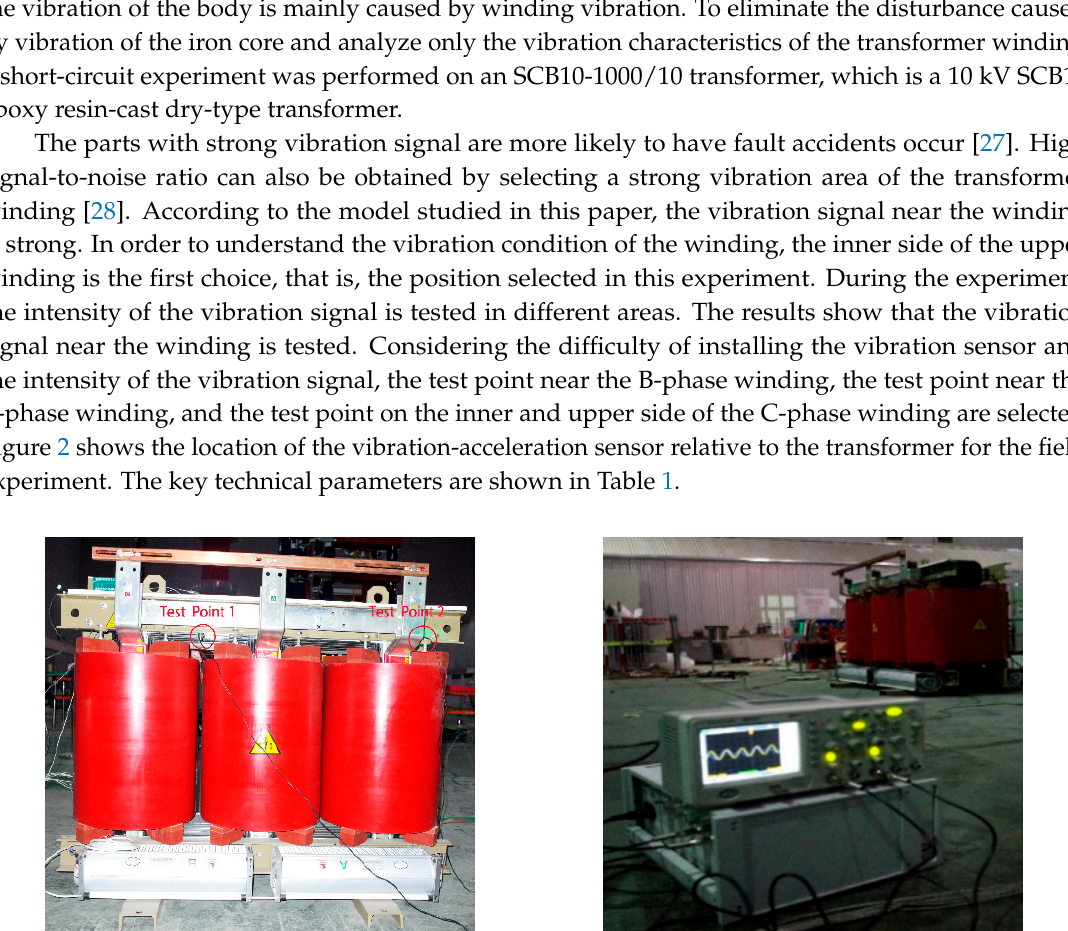
Figure 3. A set of typical mechanical-vibration signals. 3. Multiphysical Field-Coupling Model for Winding Vibration of Dry-Type Transformer In this paper, COMSOL Multiphysics software was used to simulate the vibration of the SCB10- 1000/10 dry-type transformer winding, and coupling simulation analysis of the magnetic field and the solid mechanics was performed. 3.1. Establishment and Mesh Generation of a Vibration-Simulation Model for a Dry-Type Transformer The structure of the transformer is complex and includes a variety of components such as the winding, iron core, and cooling device. For the purpose of the simulation, the transformer is simplified and treated as an ideal model in which the internal cooling device and supporting fastening components are neglected. The finite-element geometric model was set up based on the actual structural parameters of the SCB10-1000/10 dry-type transformer (Xuzhou Debon Electric Equipment Co., Ltd., Xuzhou, China), and a fixed constraint was applied at both ends of the winding to simulate clamping. To simulate the electrical insulation of the actual transformer, three-phase high- and low-voltage winding turns and layers were used, which allowed the electromagnetic field to be solved. The solid mechanics model was set up as a fully coupled solution to understand the connection between the differential equation of motion and the differential equation of the electromagnetic field. The simulation model is shown in Figure 4a. To improve efficiency, the